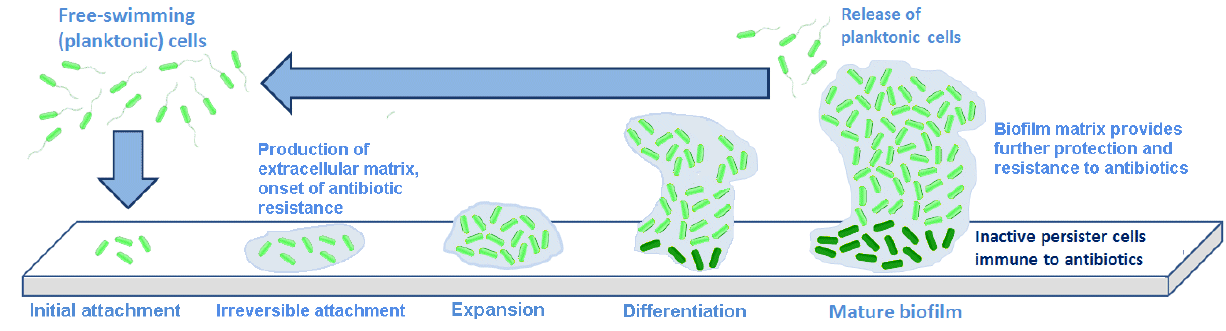
Figure 1. The life cycle of bacteria in biofilms.